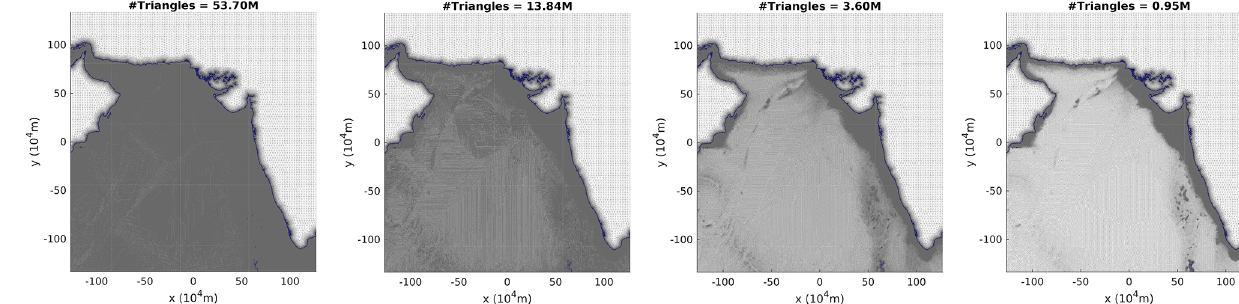
Figure 7. Non-uniform meshes corresponding to the test cases (see Table 1).